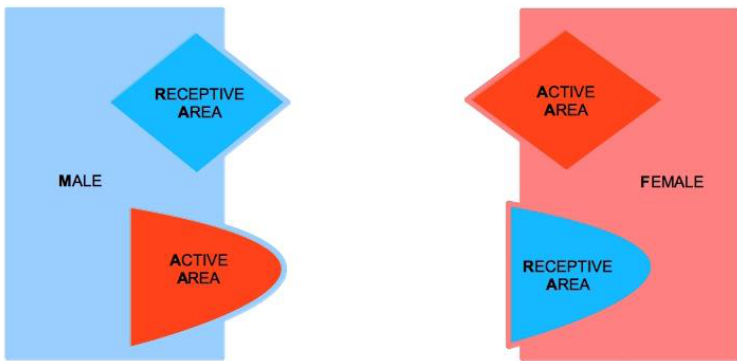
Figure 1. Male Receptive Area (M-RA), Male Active Area (M-AA), Female Active Area (F-AA), and Female Receptive Area (F-RA).